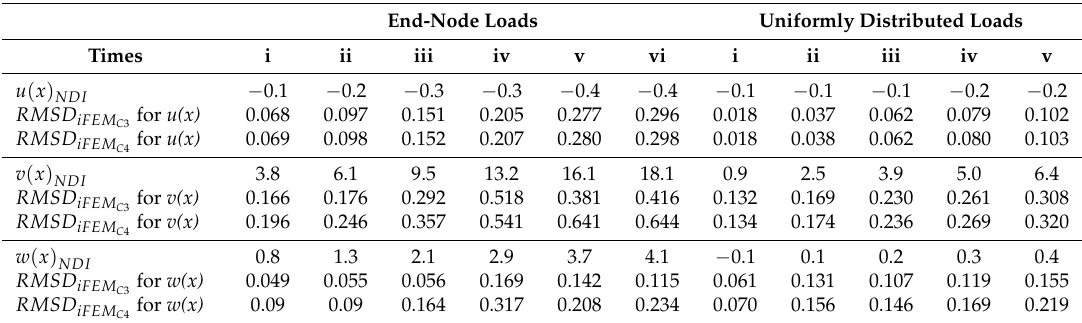
Table 9. Root-mean-square difference (RMSD) of iFEM calculation for different loads (RMSD expressed in mm). End-Node Loads Uniformly Distributed